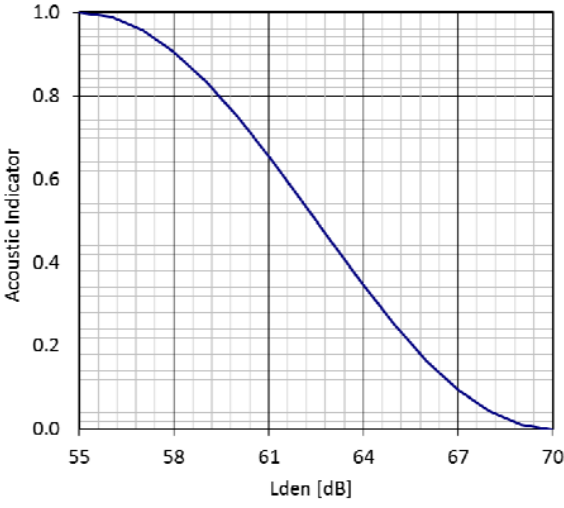
Figure 1: AI values referred to the noise level